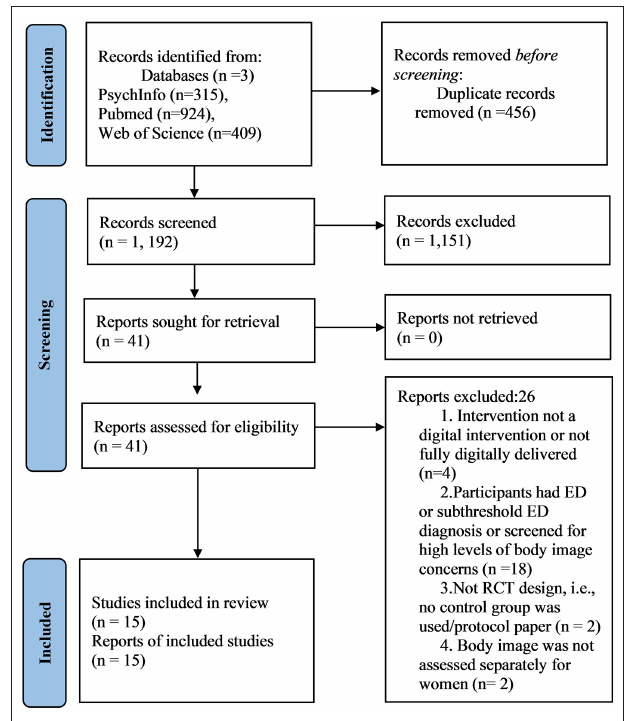
FIGURE 1 | PRISMA 2020: flow diagram for systematic